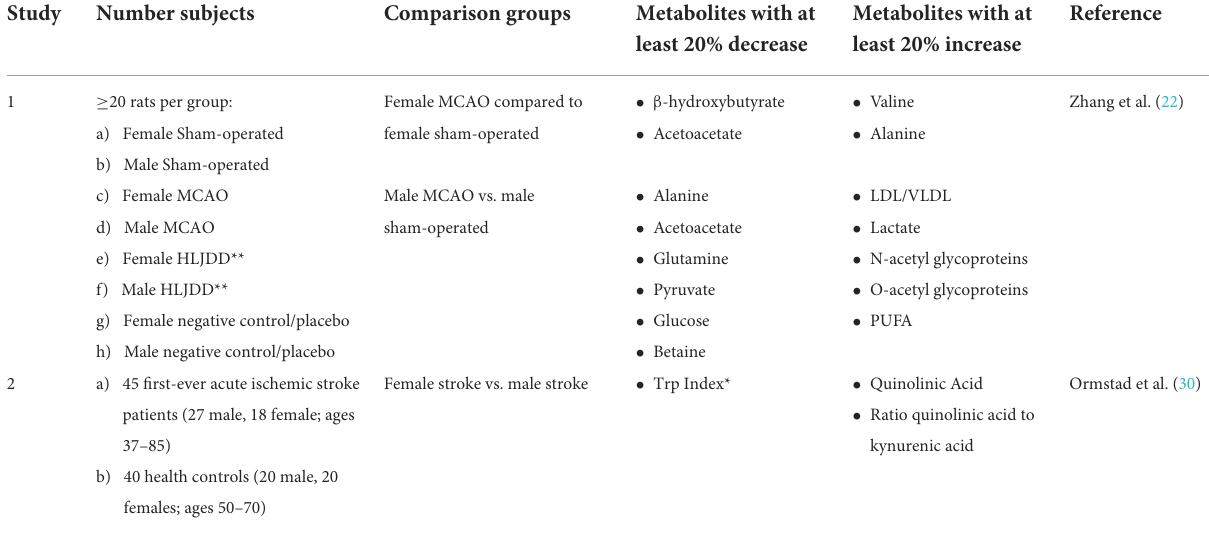
TABLE 1 Summary of included